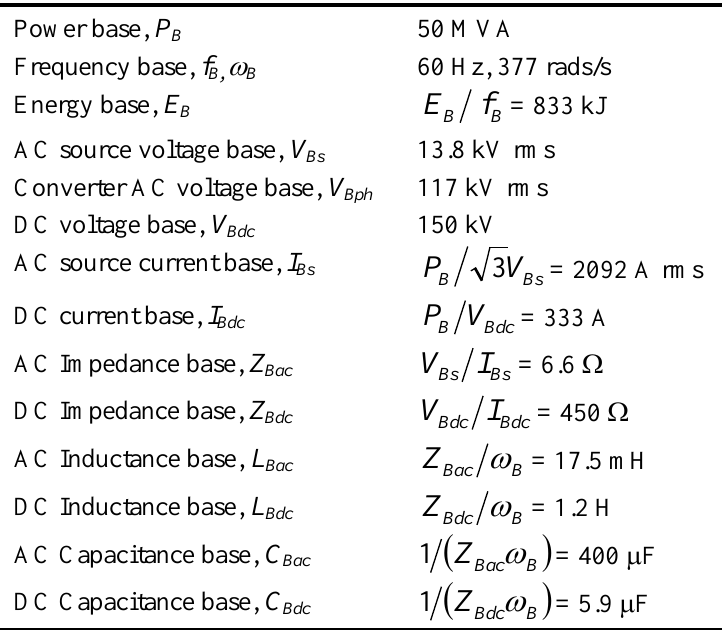
Table A1. Per-Unit base quantities for benchmark